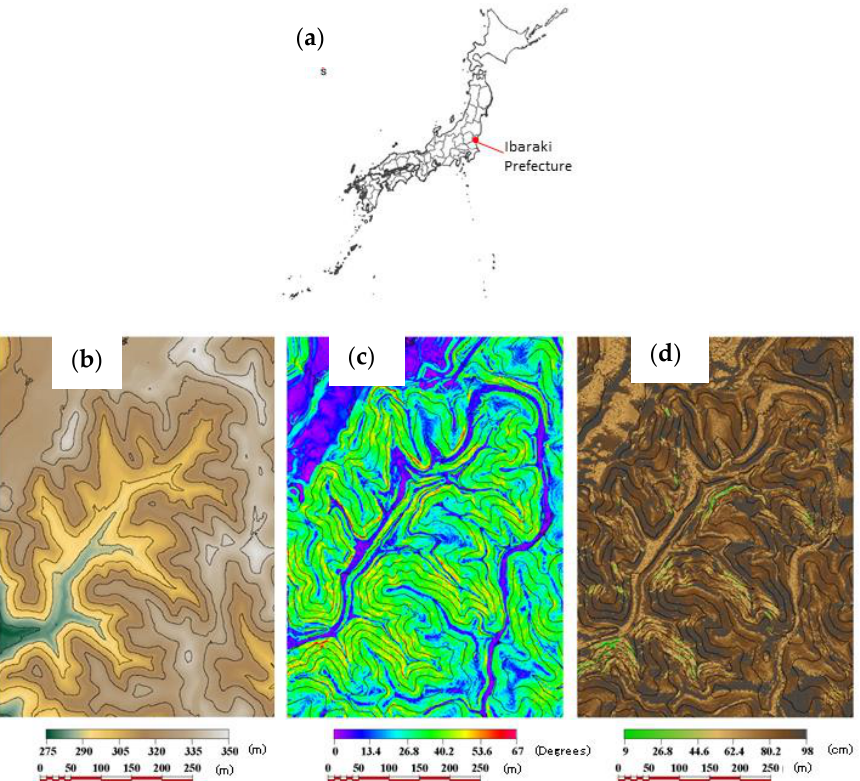
Figure 2. Topography maps of the studied forest basin. ( a ) Location of Ibaraki Prefecture. ( b ) Eleva- tion, ( c ) slope (calculated by TNTmips (Version 2019, Redmond, DC, USA)), and ( d ) soil depth.